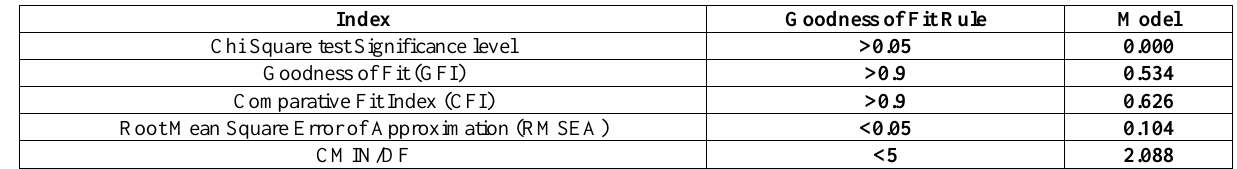
Table 4. Fitting Index of Confirmatory Factor Analysis of Model